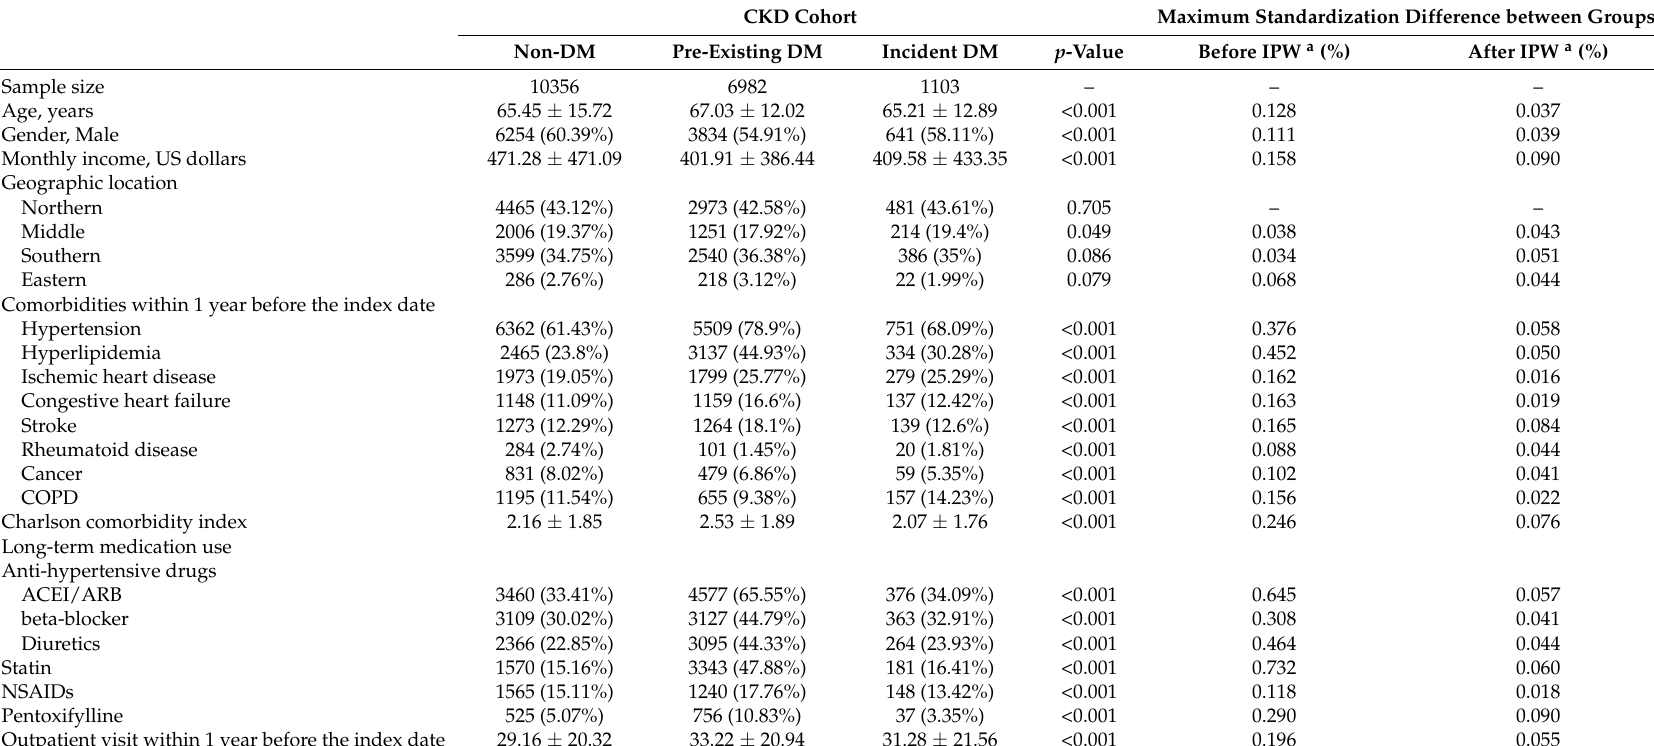
Table 1. Baseline characteristics and clinical outcomes of study patients by diabetic